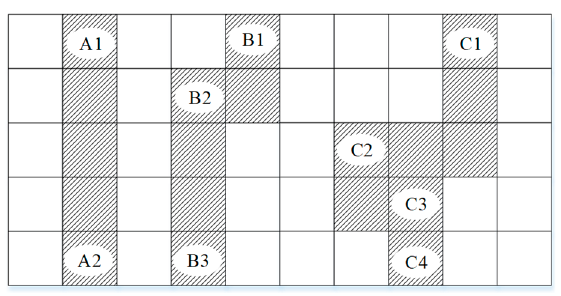
Figure 4. Schematic diagram of road ( after compression).